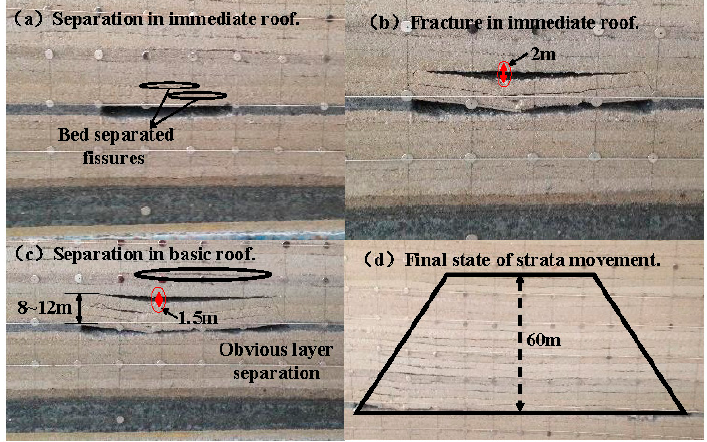
Figure 9. Movement characteristics of strata when mining the No. 4 coal seam.